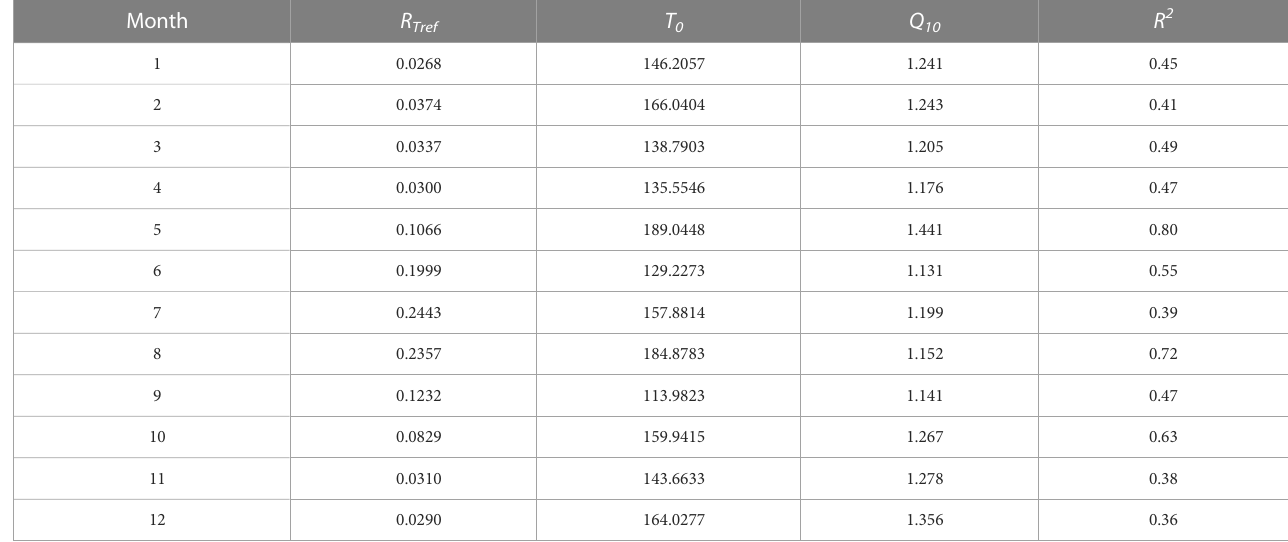
TABLE 7 Monthly respiration-temperature response equation parameters of boreal forest